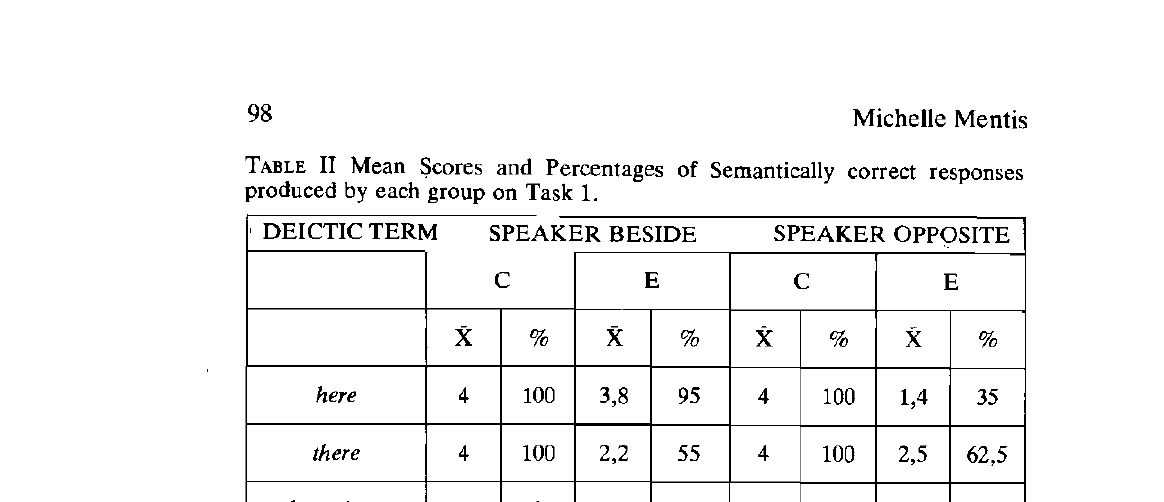
TABLE III Mean Scores of Semantically correct responses to proximal and distal terms in each of the two situations (Task 1)